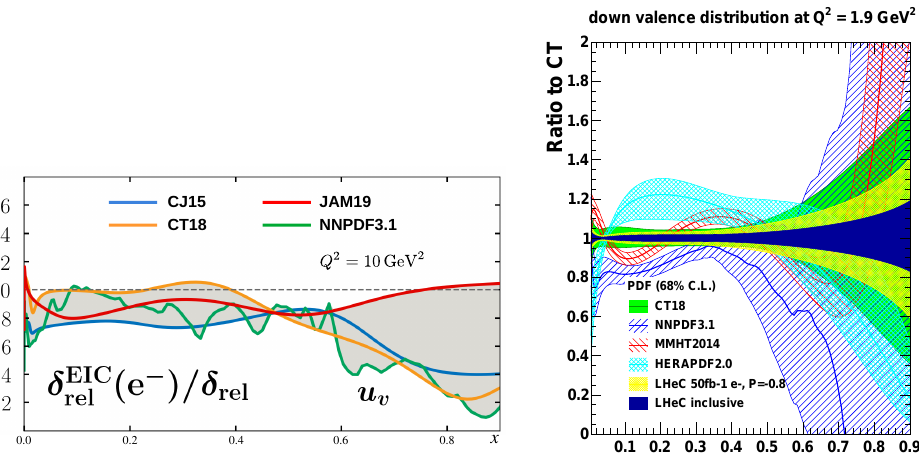
Figure 2: The EIC and LHeC will have significant constraining power of the unpo- larized PDFs of the nucleon, as illustrated here for select examples. (Left) The EIC will have the potential to reduce high- x uncertainties of the u PDF; adapted from v ( x ) at Q 2 = 10 GeV 2 after including Ref. [ 3 ] , we plot the relative uncertainty on u v 100 fb − 1 of e − EIC pseudodata, which can reduce PDF uncertainties by as much a factor of ∼ 5 at x ∼ 0.8. (Right) Analogously, analyses carried out using the xFit- ter framework [ 6 ] suggest that LHeC inclusive measurements can cut down the PDF uncertainty on the d PDF by several factors at high x . Such reductions in high- x v valence-PDF uncertainties will be instrumental for enhancing the precision of BSM searches in, e.g. , the tails of rapidity distributions in high-mass Drell-Yan at the HL- LHC. Panel taken from Ref. [ 5 ]